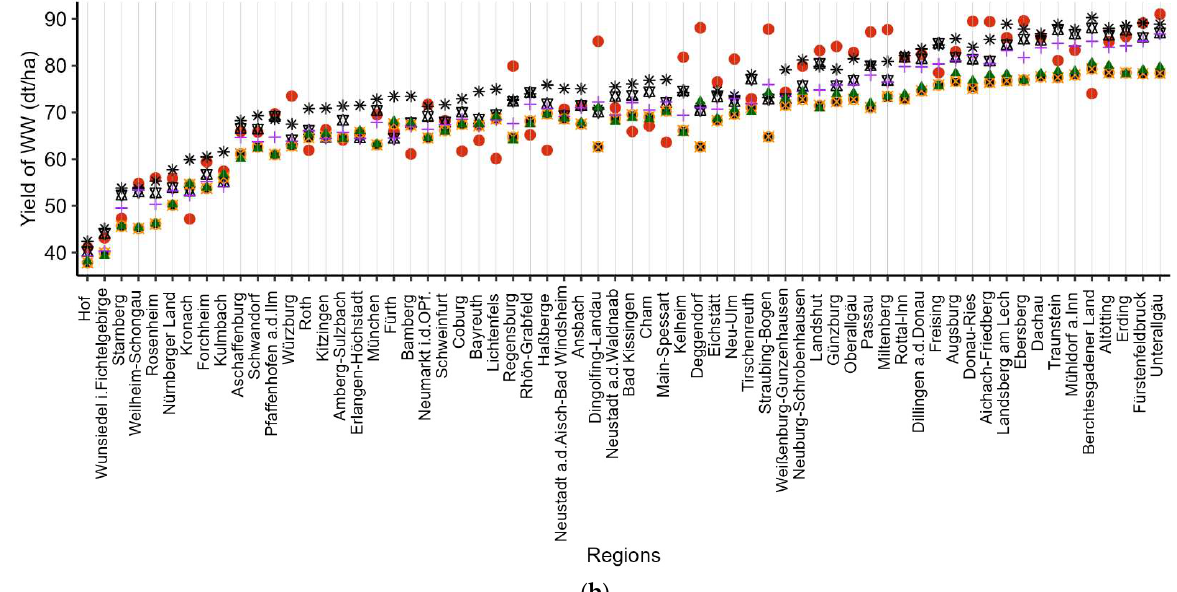
Figure 11. The dot plots show the region-wise distribution of referenced yields and modelled yields obtained from multi-source data (MOD13Q1 (8 and 16 days), L-MOD13Q1 (8 and 16 days), and S-MOD13Q1 (8 and 16 days)) for WW using ( a ) LUE and ( b ) WOFOST in 2019. The regional referenced yields are displayed in red dots.